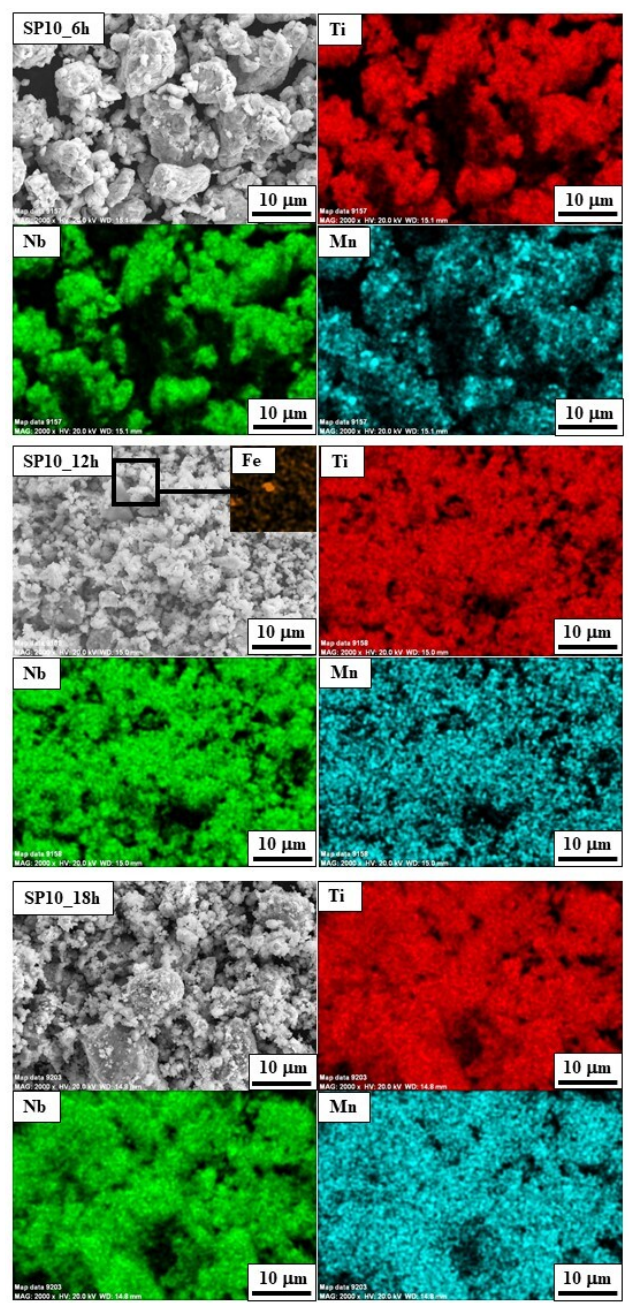
Figure 6. Characteristic compositional XEDS-SEM mapping for the elements existing in the SP10 specimens milled at 6 h, 12 h, and 18 h. Ti: red; Nb: green; Mn: light blue; Fe: orange.